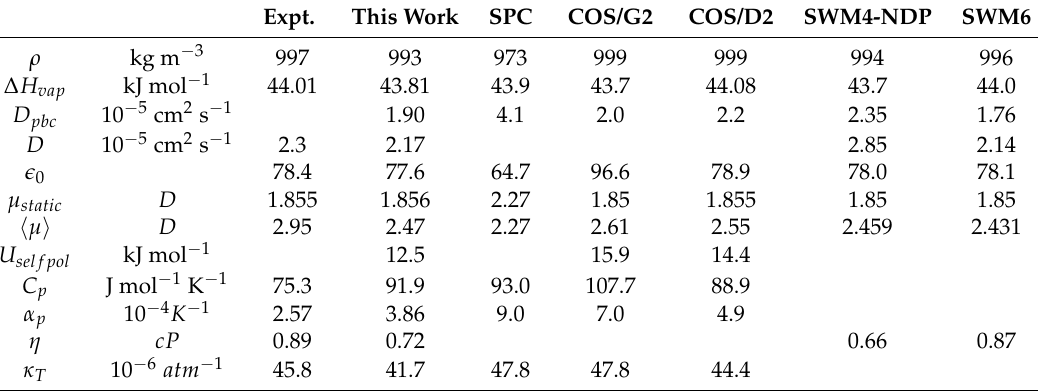
Table 2. Pure-liquid properties of water as calculated from a 10 ns NpT simulation at 298.15 K and 1 atm (This work). Reference experimental data (Expt.) are listed for the density ( ρ ) [14,70], heat of vaporization ( ∆ H vap ) [14,71], diffusion constant (corrected for box size, D ) [72], static dielectric permittivity ( (cid:101) 0 ) [33], the static ( µ static ) [65] and averaged molecular dipole moment ( constant-pressure heat capacity ( C p ) [73], thermal expansion coefficient ( α p ) [14,70], shear viscosity ( η ) [74], and isothermal compressibility ( κ T ) [75]. Values for the diffusion constant under periodic boundary conditions ( D pbc ) and the self-polarization energy ( U selfpol ) are also listed. Values for SWM4-NDP and SWM6 water models were taken from Ref. [7] and values for SPC, COS/G2 and COS/D2 were taken from Ref. [8].